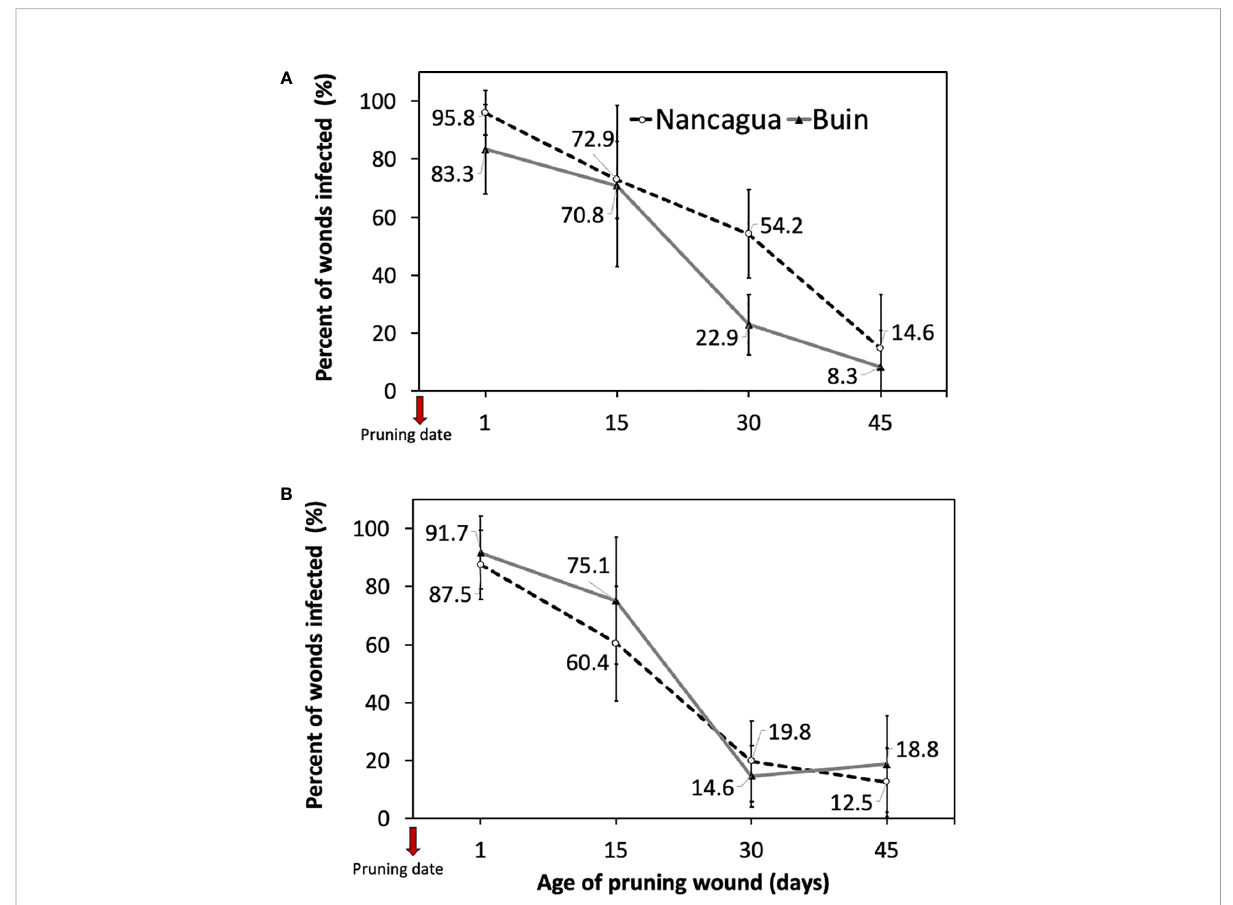
FIGURE 6 Percent of grapevine pruning wounds infected expressed as mean (%) ± standard deviation caused by arti fi cial inoculation of 40 uL of a conidial suspension (10 5 conidia/mL) of Phaeomoniella chlamydospora on pruning wound of different ages of spurs cv. Cabernet Sauvignon at 1, 15, 30, and 45 days after pruning in the commercial vineyards located in Buin (line) and Nancagua (segmented line), during eight months from the dormant season of 2014 (A) and 2015 (B) in Central Chile.